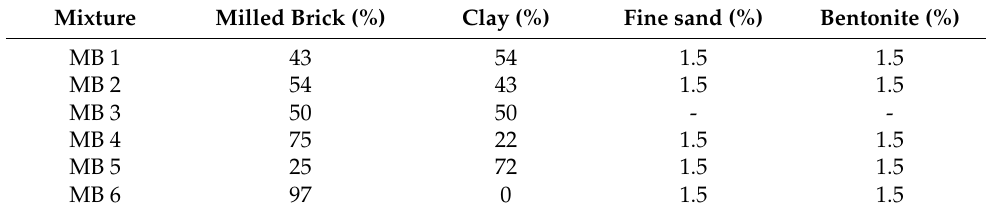
Table 3. Mix ratio for milled brick (MB) used in lab testing.